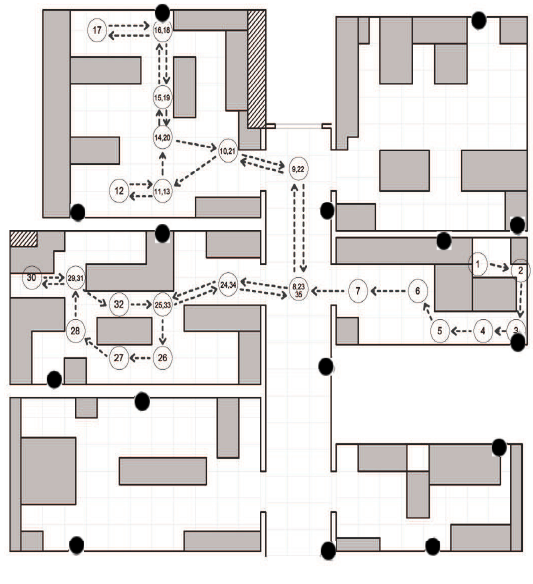
Figure 5. Deployed anchors and the second path: three rooms and the hallway are used during this